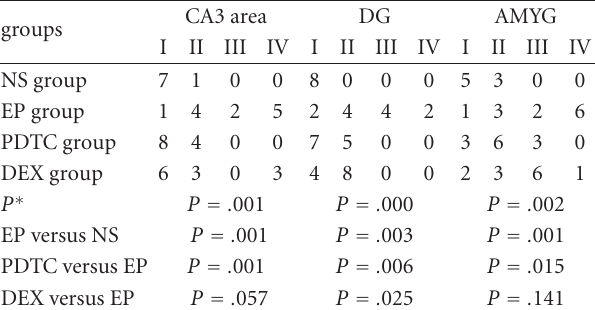
Table 1: NF- κ B p65 expression in each group (the number of cases).